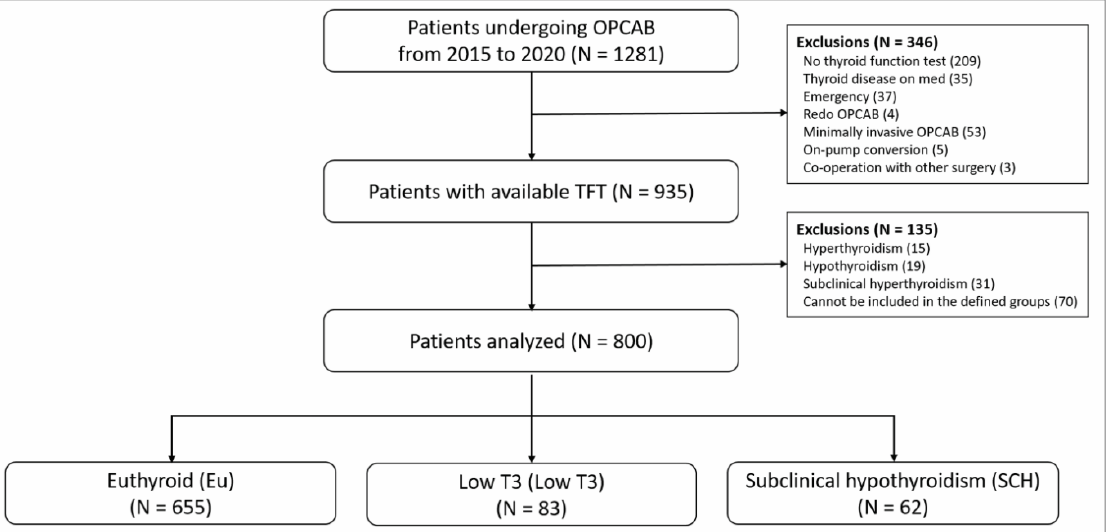
Figure 1. Flow chart of patients’ enrollment. OPCAB (off-pump coronary artery bypass graft); SCH (subclinical hypothyroidism); TFT (thyroid function test); T3 (triiodothyronine).